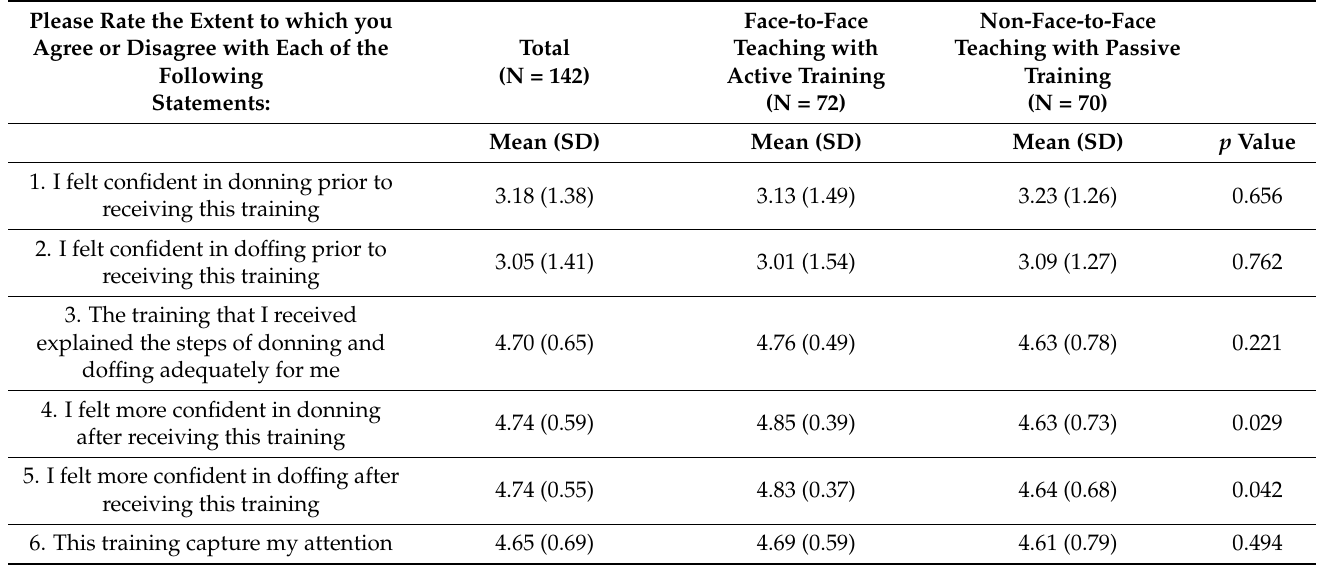
Table 3. Self-assessment of the management of PPE in the total study population and according to the training modalities (mean of the response